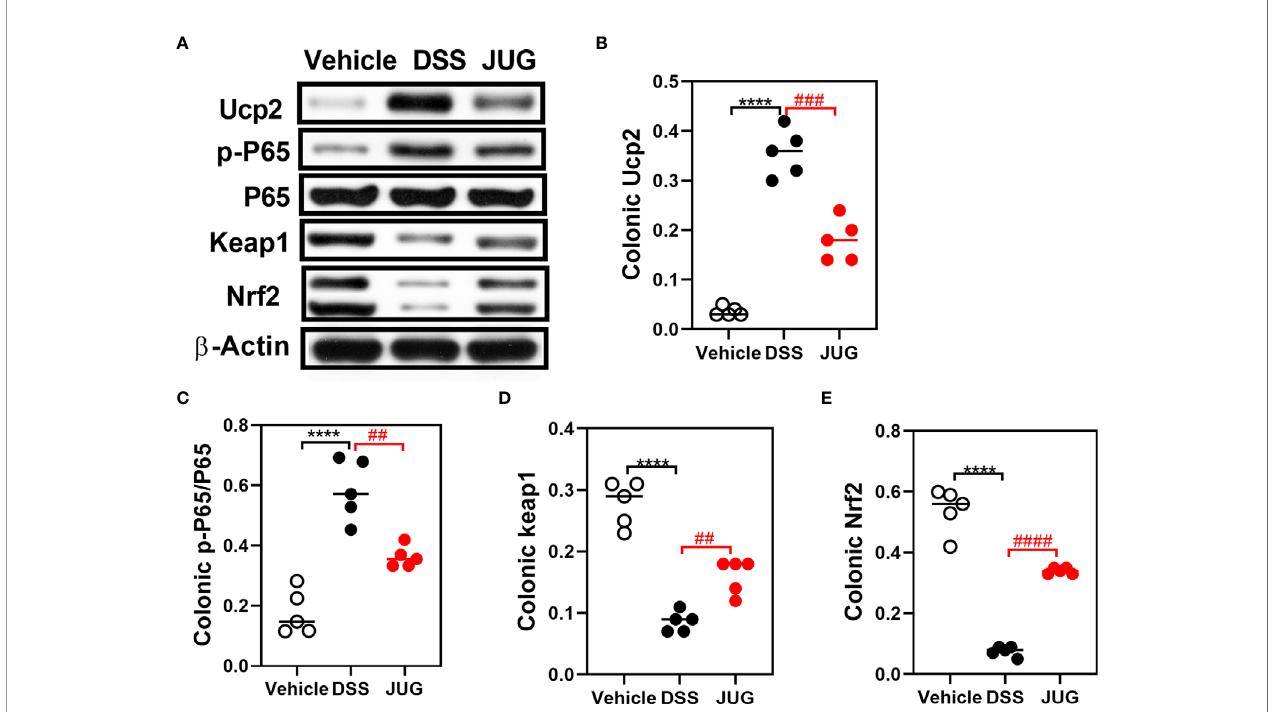
FIGURE 5 | WB for analysis of the DSS-induced oxidative damage. Colonic p-P65, P65, Keap1 Ucp2, and Nrf2 expression on the protein level were analyzed by WB. (A) Representative western blot images of the colonic p-P65, P65, Keap1, Ucp2, NRF2, and b -Actin proteins. (B – E) Relative densitometric of Ucp2, p-P65/ P65, Keap1, and Nrf2 in the colon. **** P < 0.0001, ## P < 0.01, ### P < 0.001, #### P <